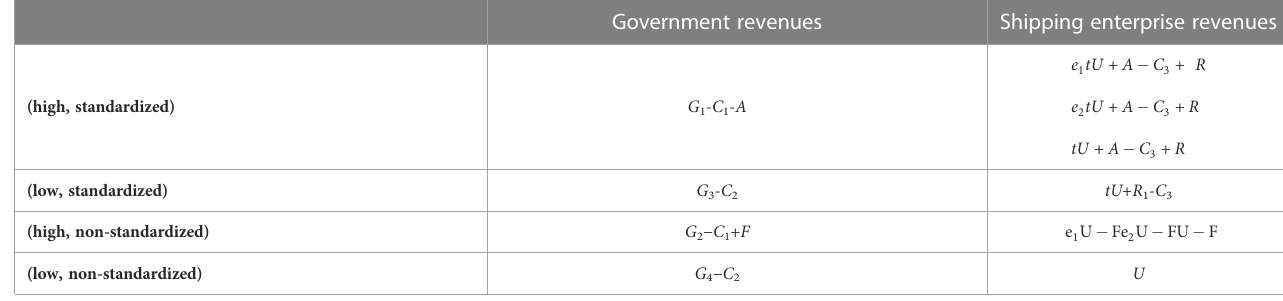
TABLE 3 Revenue matrix of the second